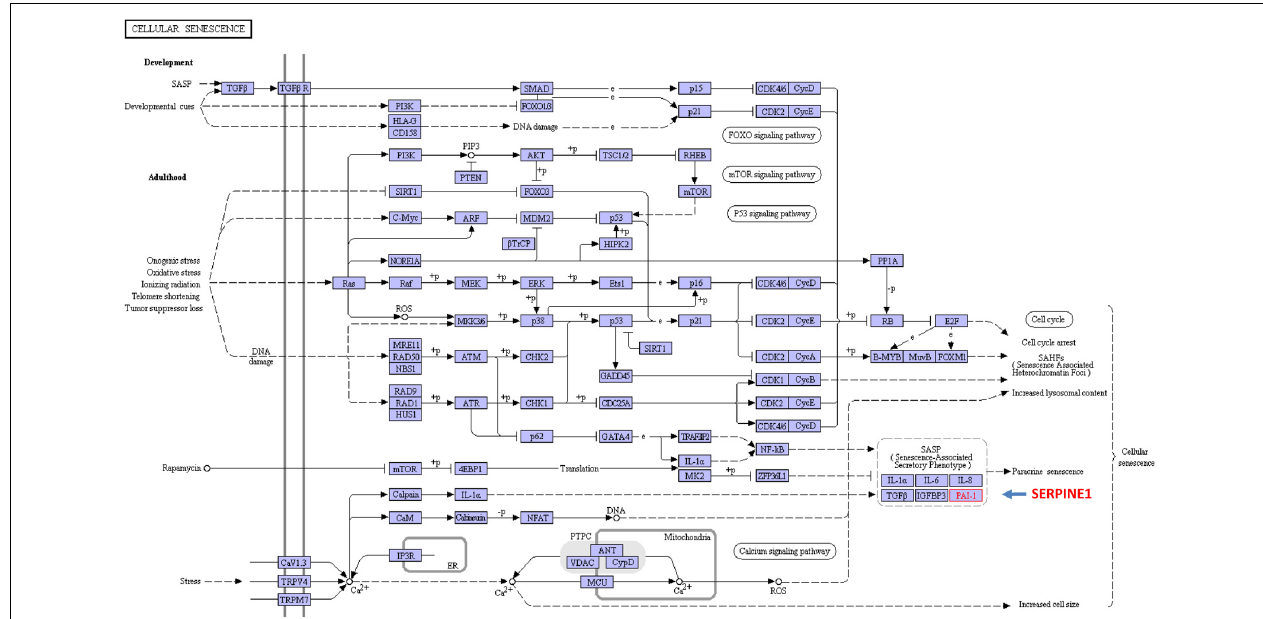
FIGURE 6 | KEGG analysis of the highly interactive program of cellular senescence. SERPINE1 and TGF- β 1, two prominent activators and members of the stress-activated SASP, are key factors in the global and renal programs of proliferative arrest. Several of the involved networks include the p53, ras and TGF- β signaling pathways. Collectively, these regulate the expression of a spectrum of cell cycle and growth control elements (e.g., p16, p21, TGF- β 1, PAI-1) (Kortlever et al., 2006,